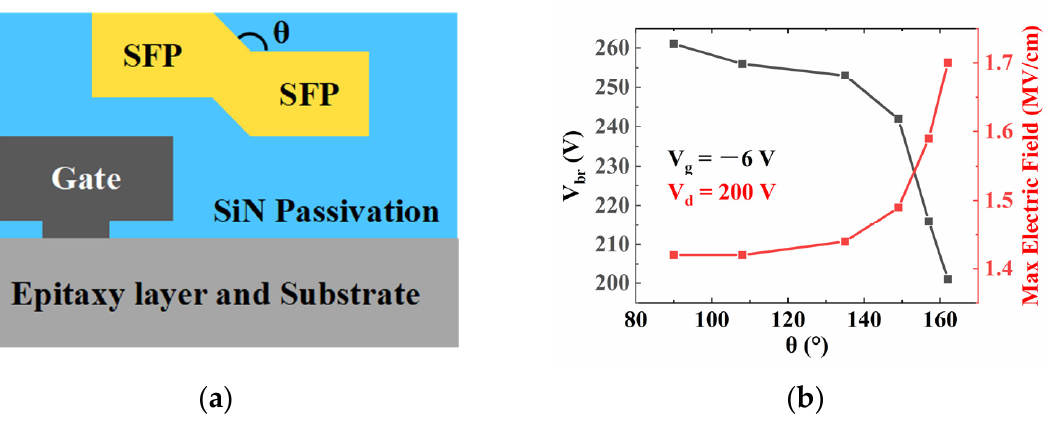
Figure 7. ( a ) Cross-sectional illustration of AlGaN/GaN HEMT with a bevel SFP; ( b ) breakdown voltage and channel electric field peak versus the bevel angle.